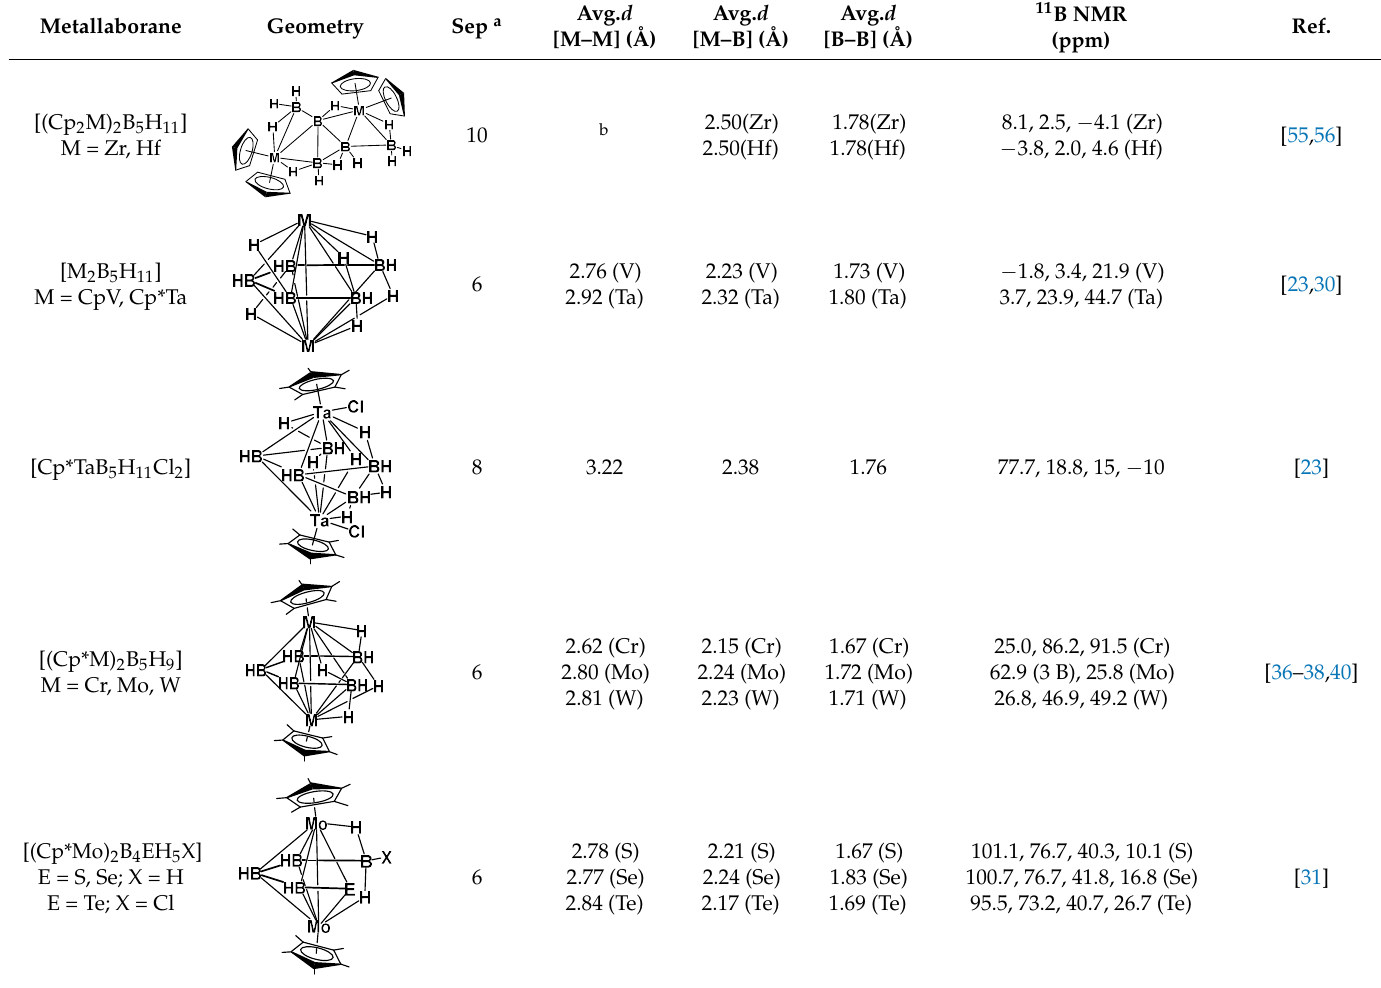
Table 2. Selected structural data and 11 B chemical shifts of different M 2 B 5 clusters from Group 4–9 metals.